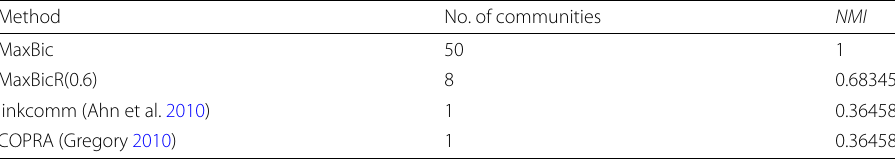
Table 7 Comparison of community numbers and NMI for NSW crime network